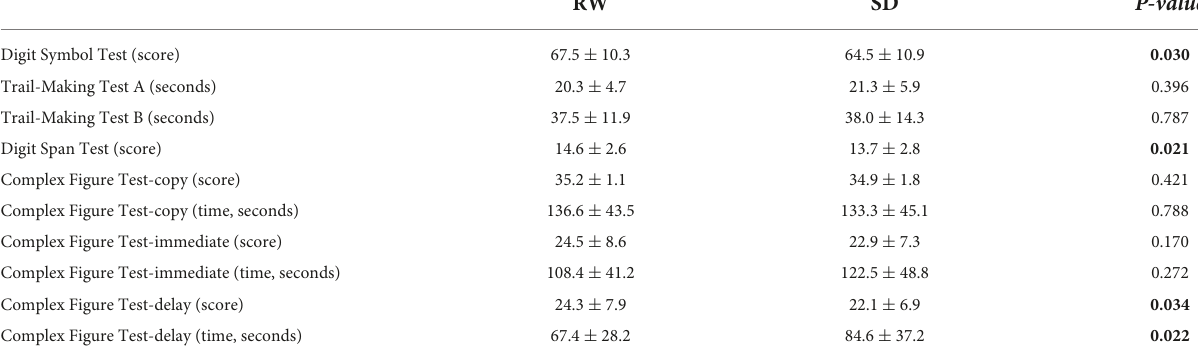
TABLE 1 Neurocognitive assessment